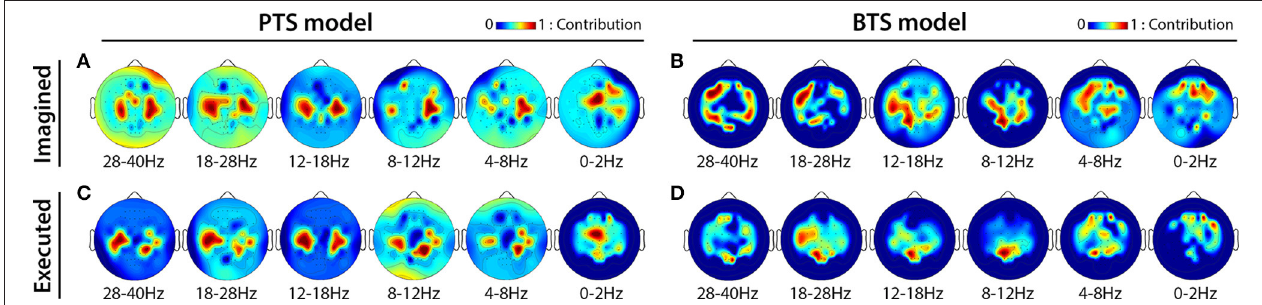
FIGURE 7 | Cross-subject based topographical maps . Topographical distribution of electrode contribution to the reconstruction of arm movement trajectory. Color coding—averaged contribution of significant channels [ p < 0.05, Student two-tailed t -test corrected for FDR (false discovery rate)] based on accuracy rates of single channel setups over 12 subjects indicating cortical areas providing a high contribution for trajectory decoding. (A,C) present topographical maps for imagined and executed arm movements using band-pass filtered potentials for the PTS model, respectively. (B,D) Present topographical maps for imagined and executed arm movements using PSD values for the BTS model, respectively.